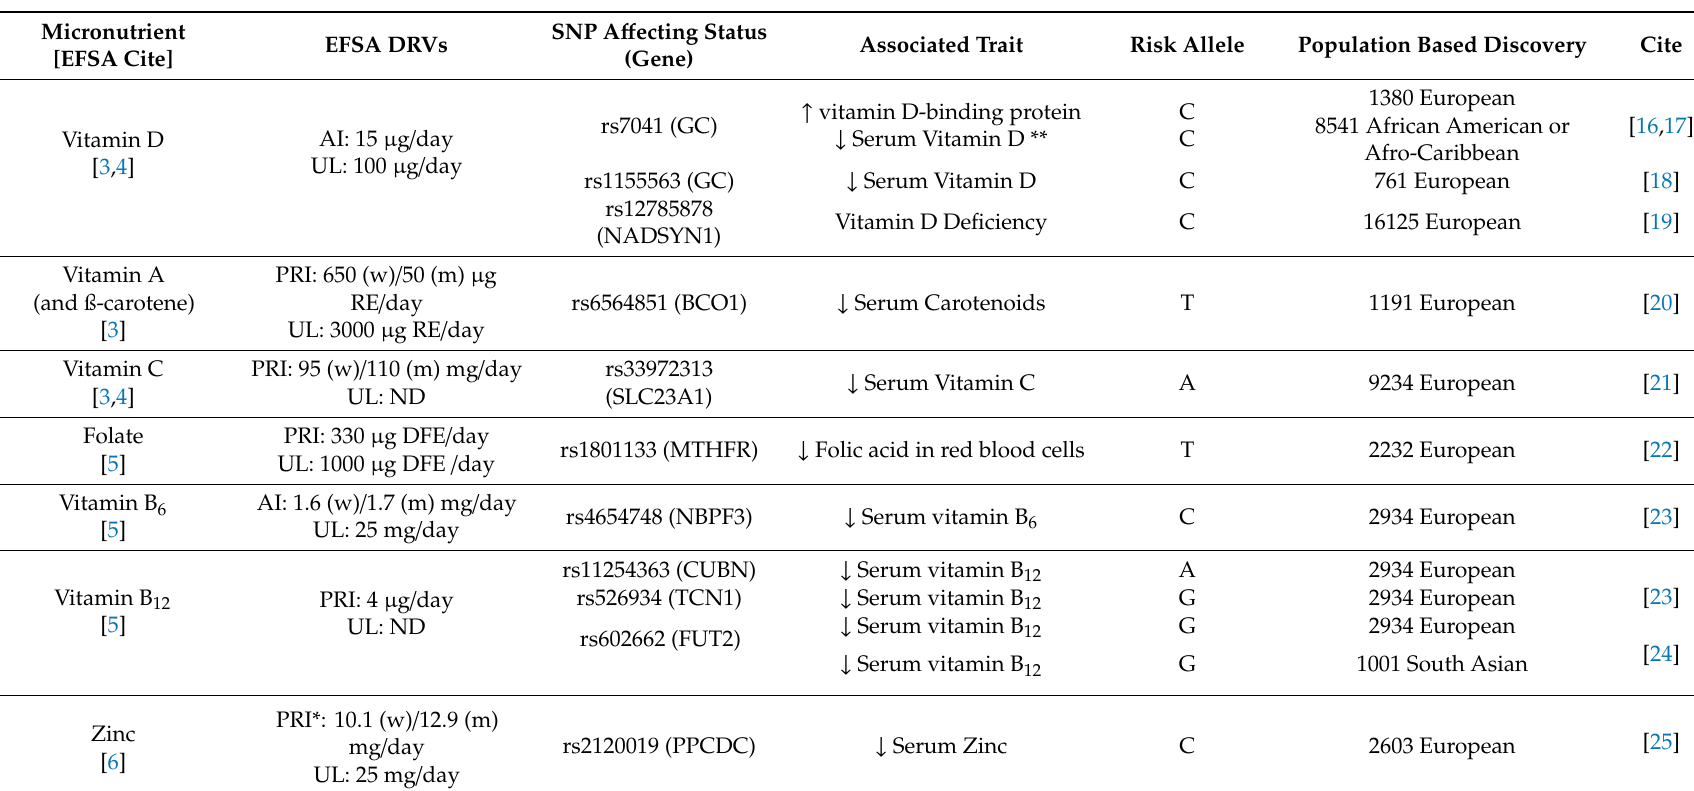
Table 1. List of nutrients with contribution to the functioning of the immune system endorsed by the European Food Safety Authority (EFSA); Dietary Reference Values (DRVs); genetic factors that a ff ect nutritional status and risk allele that predisposes to lower status; population in which the association was proven; and bibliographic citation of the genetic association paper. Dietary Reference Intakes were consulted on EFSA DRV Finder interactive tool [15]. Zinc PRIs * co-depend on Phytate intake levels and are expressed here as the mean of 300, 600, 900, and 1200 mg / day PRI